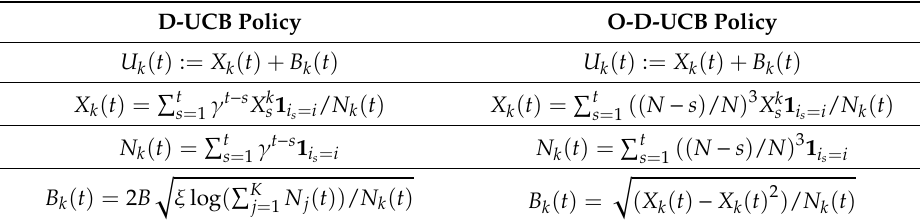
Table 4. D-UCB and O-D-UCB corresponding